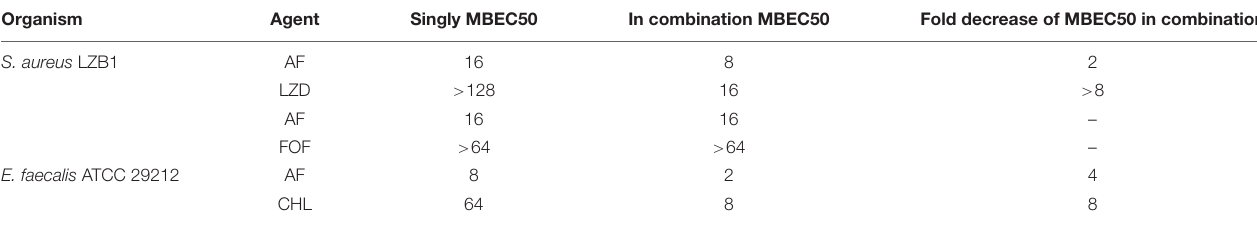
TABLE 4 | Activity of AF in combination with conventional antibiotic against preformed biofilms (mg/L). Organism Agent Singly MBEC50 In combination MBEC50 Fold decrease of MBEC50 in combination